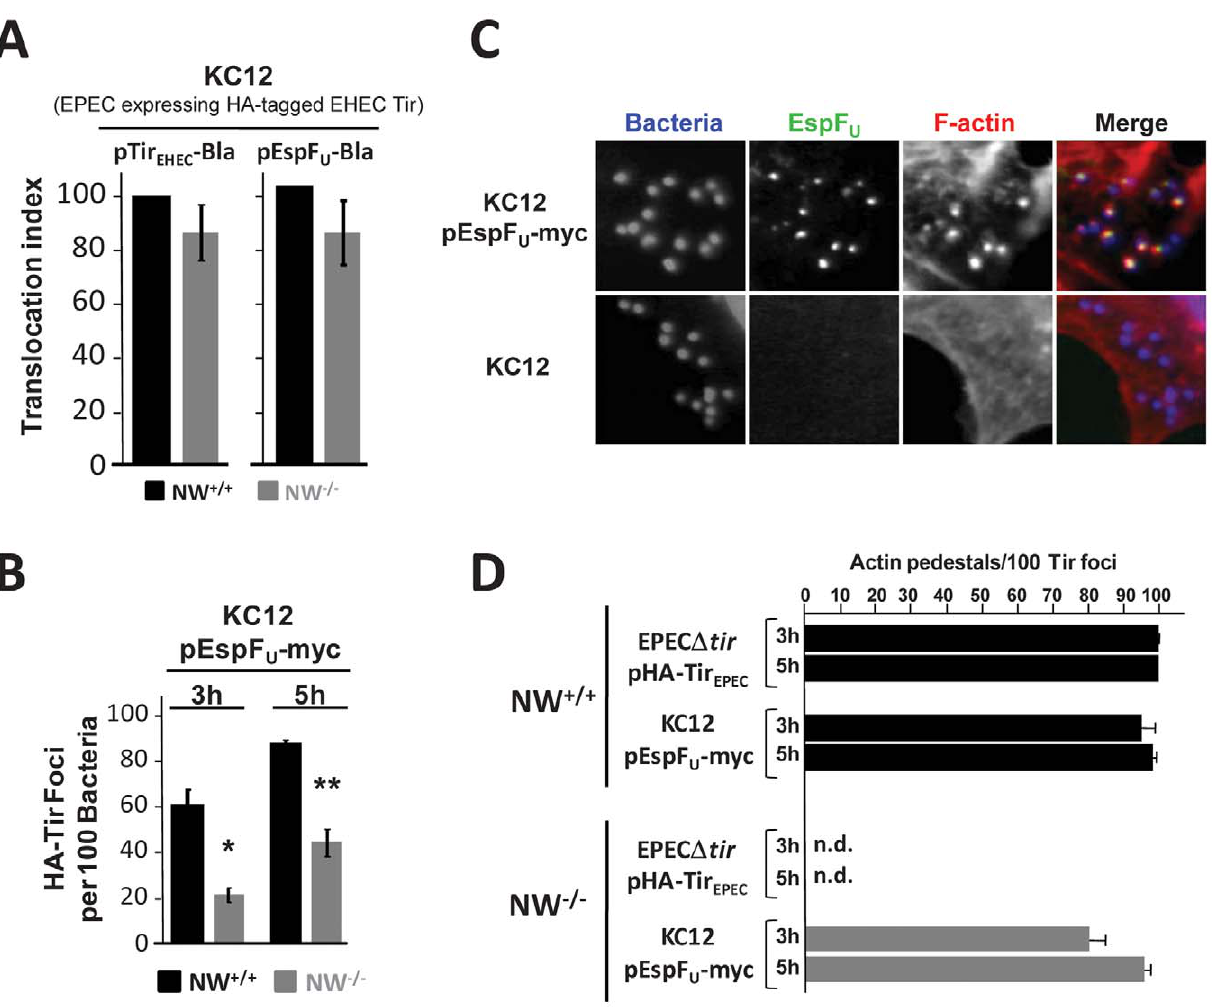
Figure 3. Tir EHEC and EspF U promote pedestal formation in the absence of N-WASP. ( A ) Translocation of the Tir EHEC -Bla and EspF U -Bla fusions by KC12 in NW + / + and NW 2 / 2 FLCs was measured 6 hours postinfection in the TEM-1 b -lactamase translocation assay as described in Figure 1. Shown is the mean 6 SD of three experiments. ( B ) NW + / + and NW 2 / 2 cells were infected with KC12/pEspF U -myc, and the percentage of HA-Tir foci associated with bound bacteria was determined at 3 and 5 hours postinfection. Values represent the mean 6 SD of three experiments; * P , 0.05; ** P , 0.01. ( C ) NW + / + and NW 2 / 2 cells were infected with KC12 or KC12/pEspF U -myc and examined after staining with DAPI, anti-myc antibody and Alexa568-phalloidin. ( D ) NW + / + or NW 2 / 2 cells were infected with EPEC D tir /pHA-Tir EPEC or KC12/pEspF U -myc, and then fixed, and stained with DAPI, anti-HA antibody to visualize Tir foci and Alexa568-phalloidin. To quantitate pedestal formation, the percentage of actin pedestals that colocalized with HA-Tir foci-associated bacteria at 3 and 5 hours postinfection was determined visually by fluorescent microscopy (right panel). Data represent the mean 6 SD from three experiments. ‘‘n.d.’’; not detected.